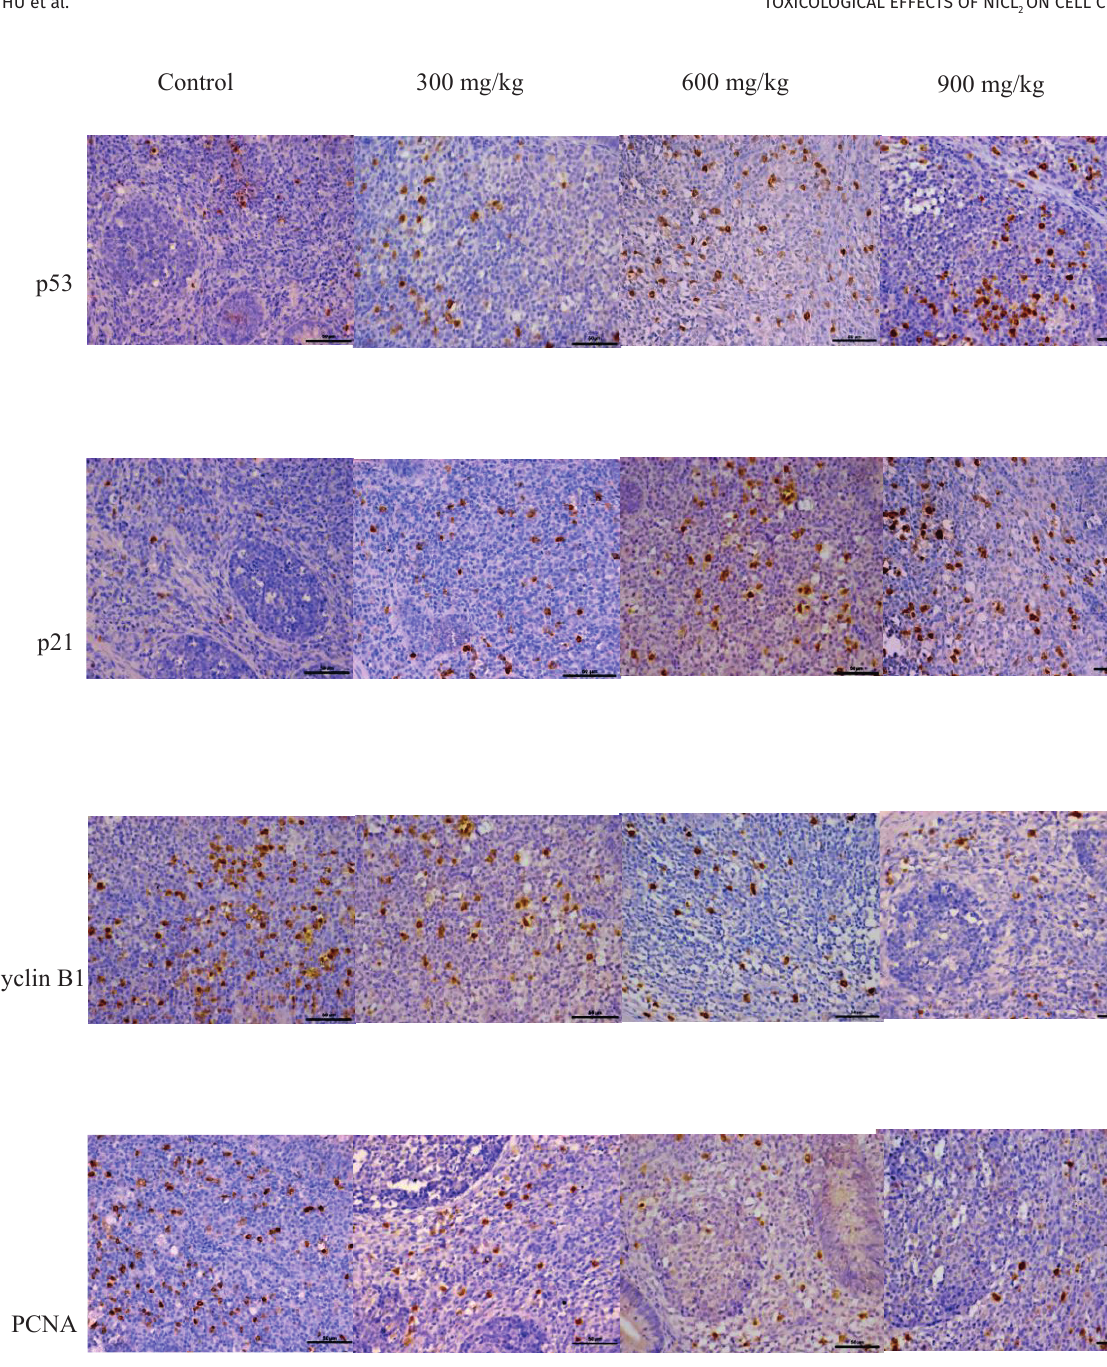
Figure 2. Changes of p53, p21, Cyclin B1 and PCNA protein expression levels in the cecal tonsil at 42 days of age. (Immunohistochemistry, ×400).